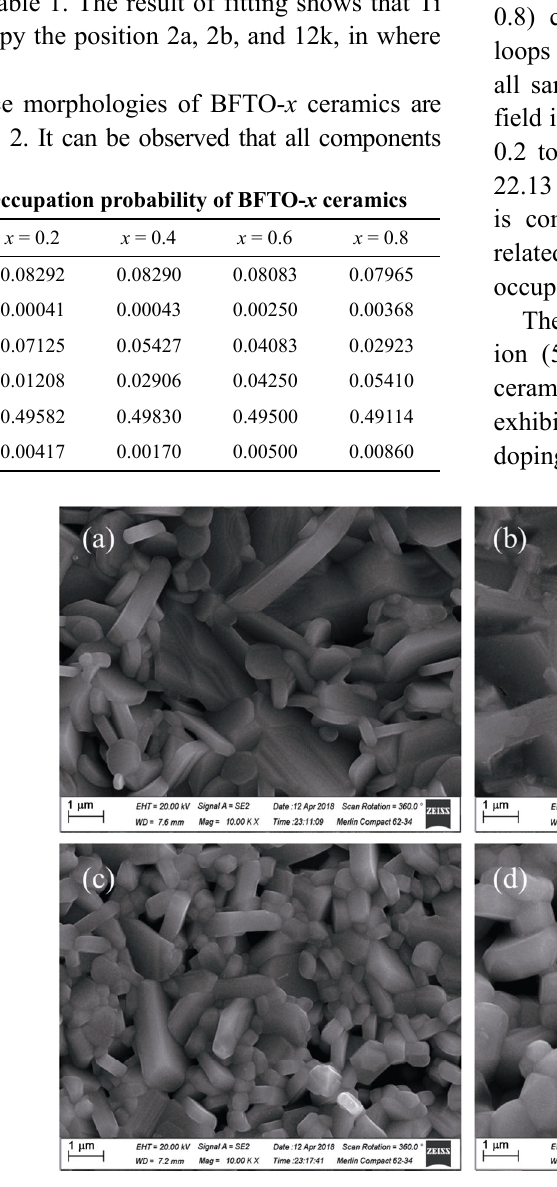
Fig. 2 SEM images of BFTO- x ceramics with (a) x = 0.2, (b) x = 0.4, (c) x = 0.6, and (d) x =